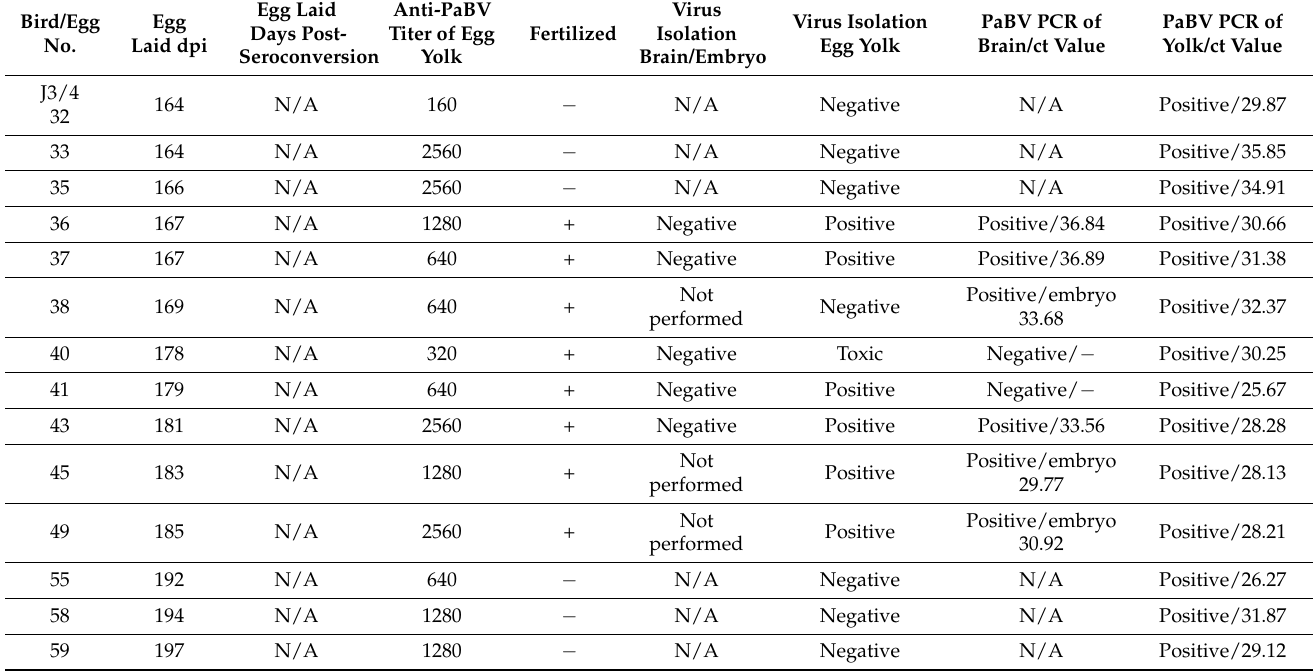
Table A2. Results of PaBV-specific PCR in embryo brains and egg yolk and results of virus isolation from embryo and egg yolk in the adult infected group sorted by egg number; “+” means the egg was fertilized, “ − “ means the egg was unfertilized. Eggs with the same dpi were laid on the same day in one nest (in nos. 86 and 90, the brain could be examined separately despite the embryo dying until day 17 in the